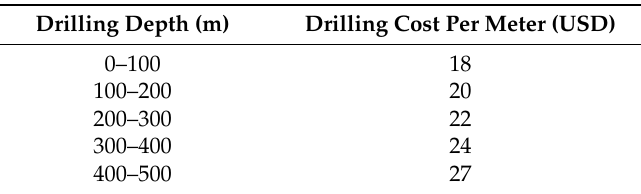
Table 7. Number of drilled boreholes and drilled depth of each case.